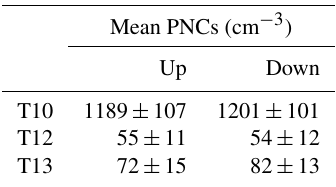
Table 6. Mean PNC with standard deviations on the way up and down in three vertical profile